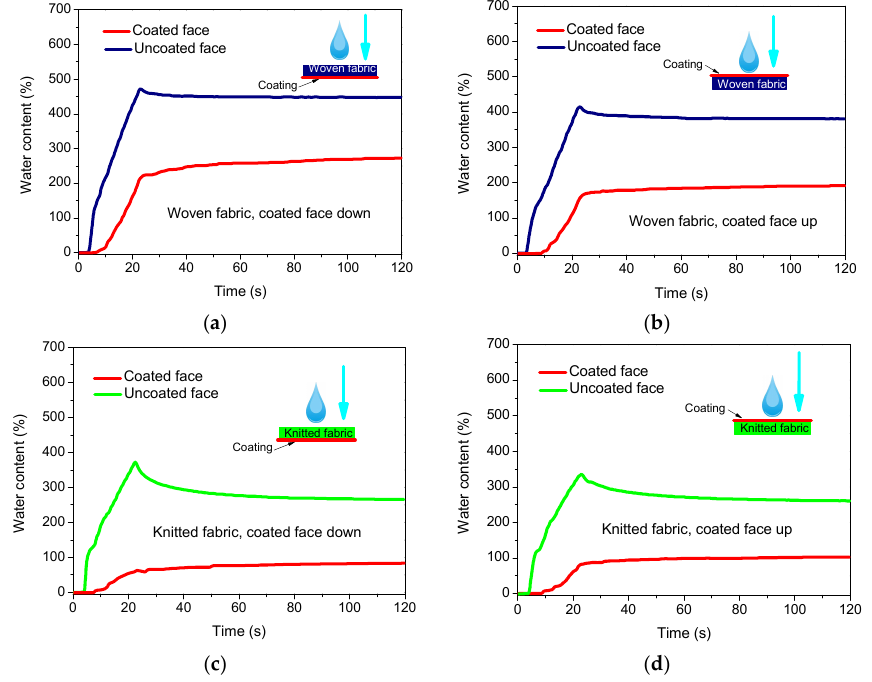
Figure 8. Typical MMT water content curves of ( a , b ) knitted fabrics and ( c , d ) woven fabrics with the red line presenting the coated face.